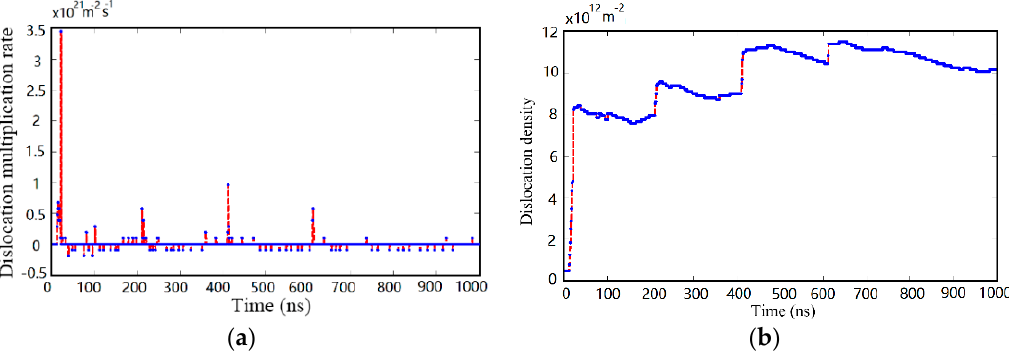
Figure 11. The evolution process of dislocation multiplication rate and dislocation density during continuous irregular cutting process. The red line represents the significant change of variables, and the blue line represents the gradual evolution of variables. ( a ) Dislocation multiplication rate evolution; ( b ) dislocation density evolution.